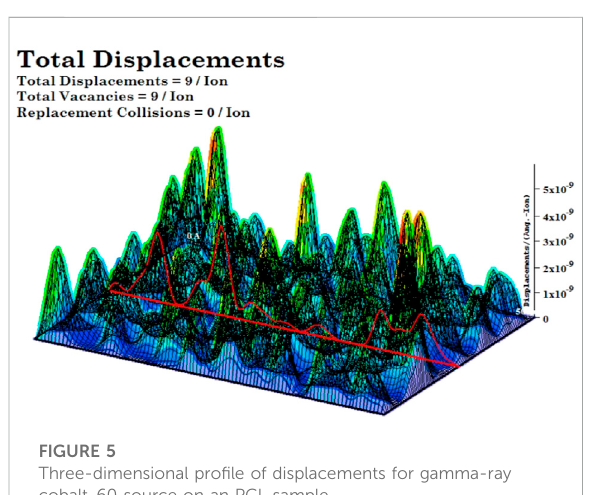
FIGURE 5 Three-dimensional pro fi le of displacements for gamma-ray cobalt-60 source on an PCL